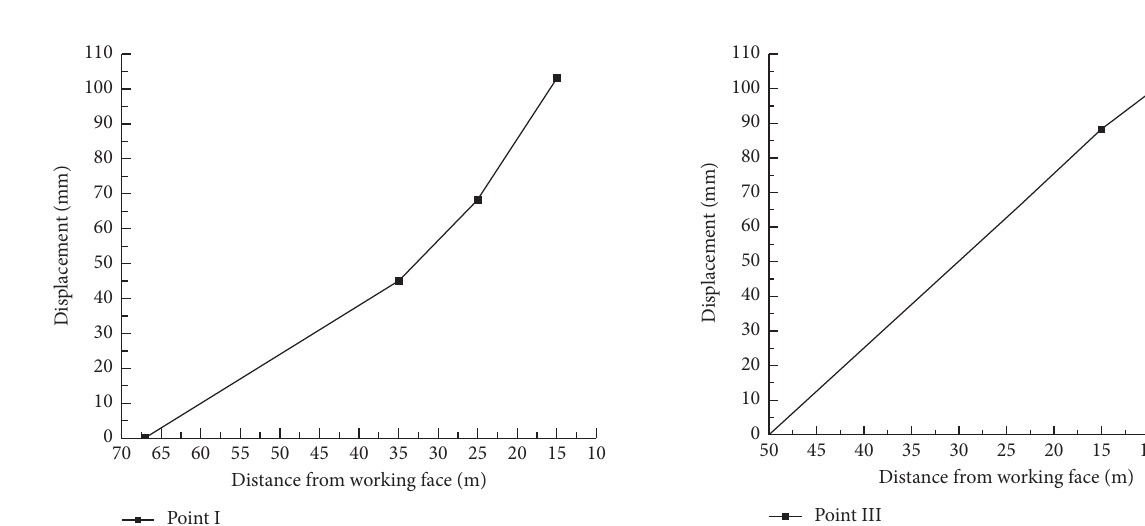
Figure 7: Displacements of roof and floor at Point III of auxiliary haulage